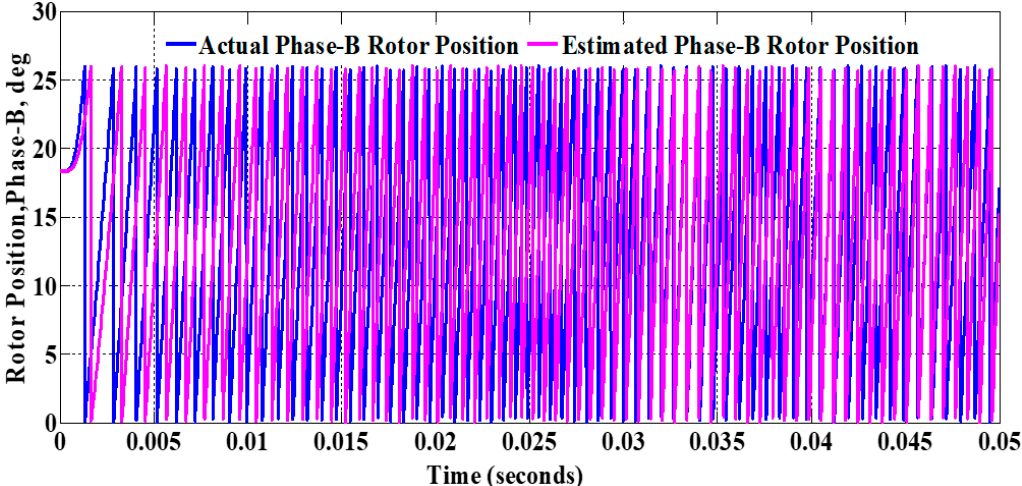
Figure 14. Estimated and actual rotor positions under phase-B.